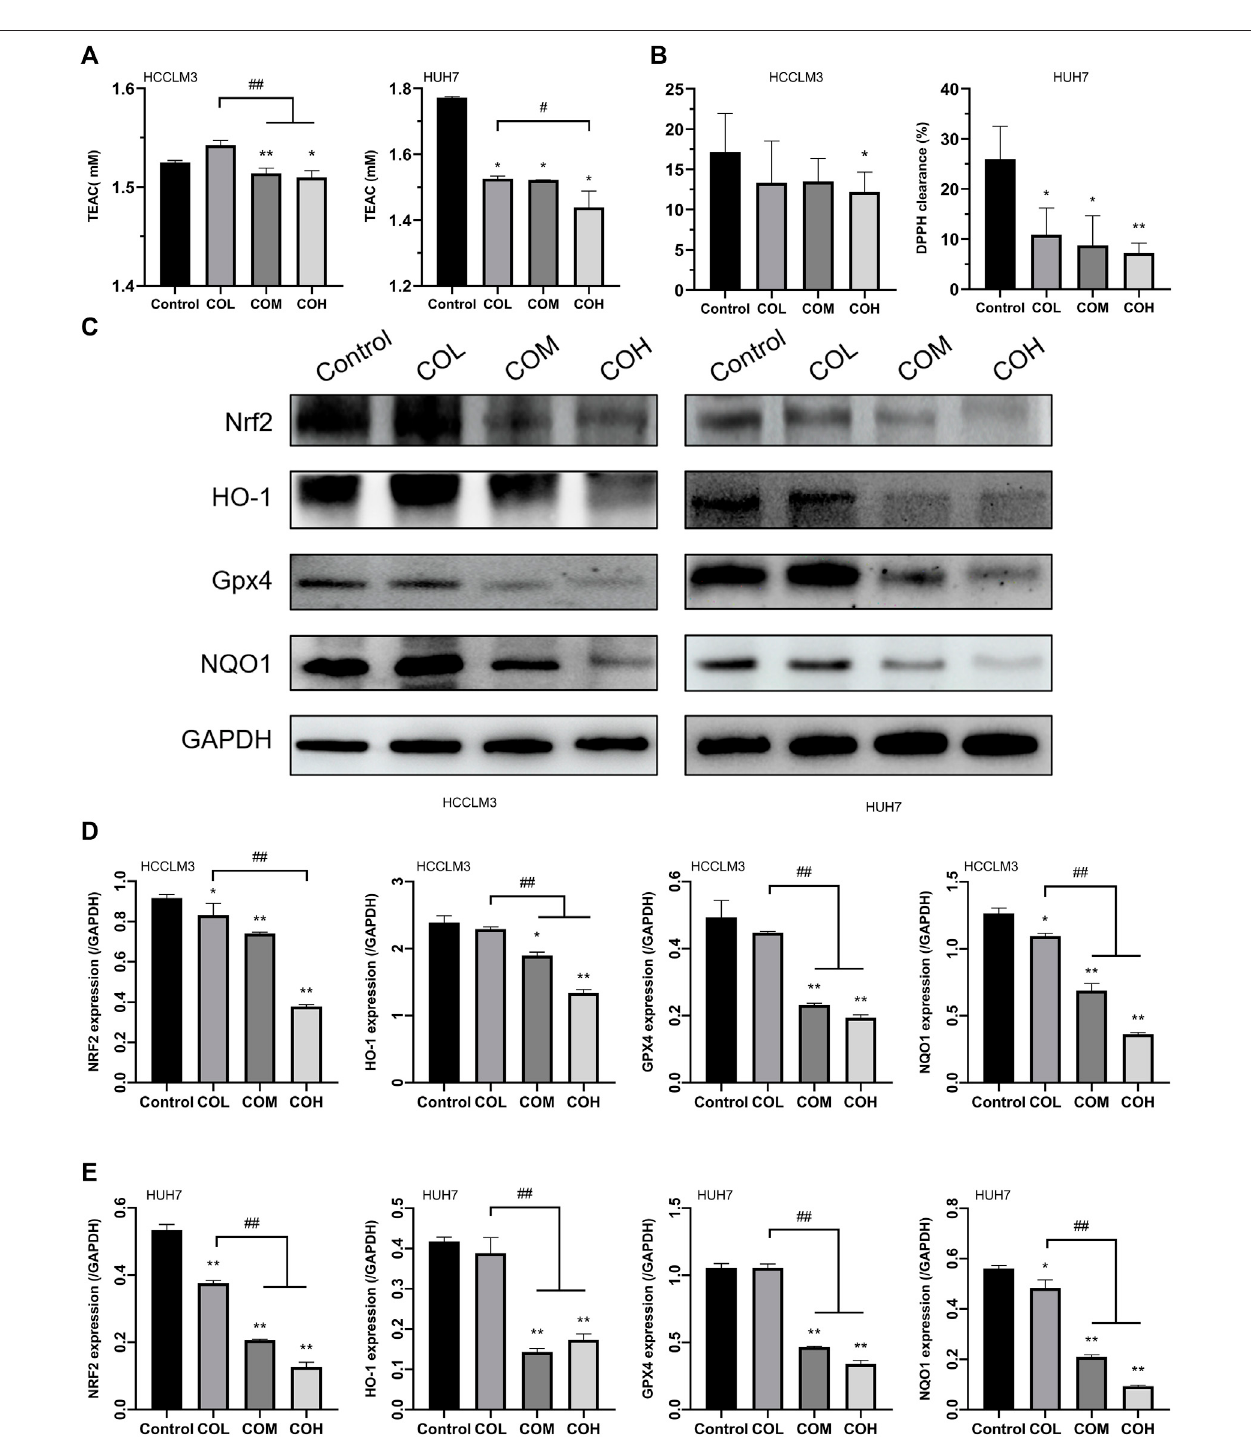
FIGURE 3 | Effects of caryophyllene oxide on intracellular antioxidant capacity and antioxidant proteins in HCCLM3 and HUH7 cells. (A) The T-AOC assay was usedtomeasuretheantioxidantcapacityofHCCLM3andHUH7cells. (B) TheDPPHfreeradical scavengingrateinHCCLM3andHUH7cells. (C) , (D) ,and (E) Western blot wasused to evaluate antioxidant protein expression in HCCLM3 and HUH7 cells. The data were presented as mean ± SD. * p < 0.05, ** p < 0.01 when compared to the control group. # p < 0.05, ## p < 0.01 when compared to the COL group.